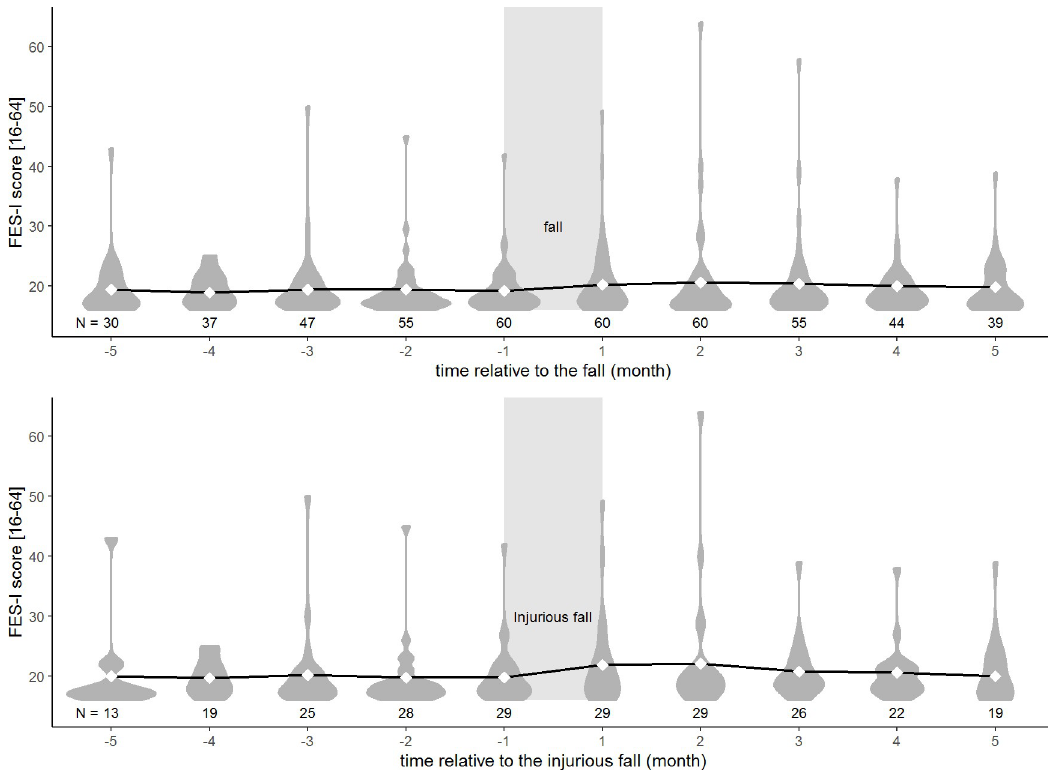
Fig 2. Progression of concern about falling before and after a fall. Distribution of FES-I scores per month are displayed in dark grey relative to the months in between which the participant experienced his or her first fall (area indicated in light gray) (-1 = last monthly questionnaire before the fall, +1 = first monthly questionnaire after the fall). Diamonds and solid line represent the mean FES-I scores and the progression of these mean FES-I scores, respectively. The dark grey areas represent the distribution of FES-I scores per month. The upper figure displays FES-I progression before and after any type of fall. The lower figure displays FES-I progression before and after an injurious fall. FES-I scores of people who fell more than once are only included until the first monthly questionnaire after the first fall. Sample size (N) is indicated for each